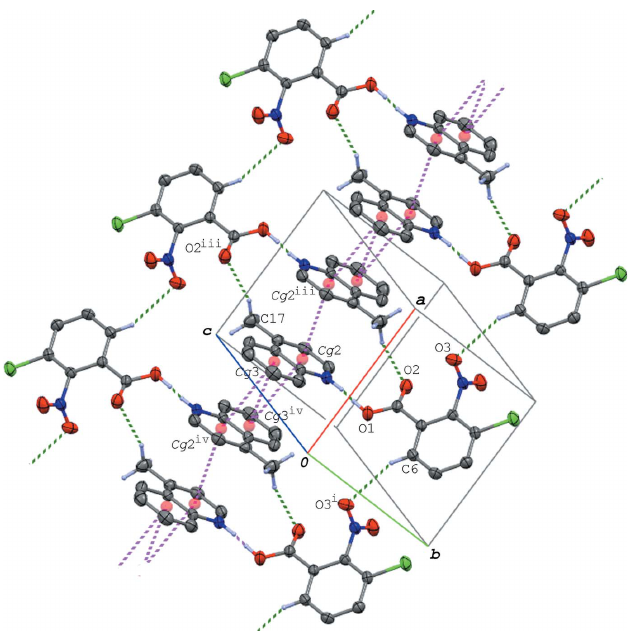
Figure 8 A packing diagram of (IV), showing the ribbon structure formed via the (cid:2) – (cid:2) interactions (magenta dashed lines), and the O—H (cid:2)(cid:2)(cid:2) N/O (cid:2)(cid:2)(cid:2) H—N and C—H (cid:2)(cid:2)(cid:2) O hydrogen bonds (green dashed lines). Except for the methyl group, H atoms not involved in the hydrogen bonds are omitted for clarity. Cg 2 and Cg 3 are the centroids of the N2/C8–C11/C16 and C11– C16 rings, respectively. [Symmetry codes: (i) x (cid:3) 1, y , z ; (iii) (cid:3) x + 1, (cid:3) y , (cid:3) z + 1; (iv) (cid:3) x , (cid:3) y , (cid:3) z +